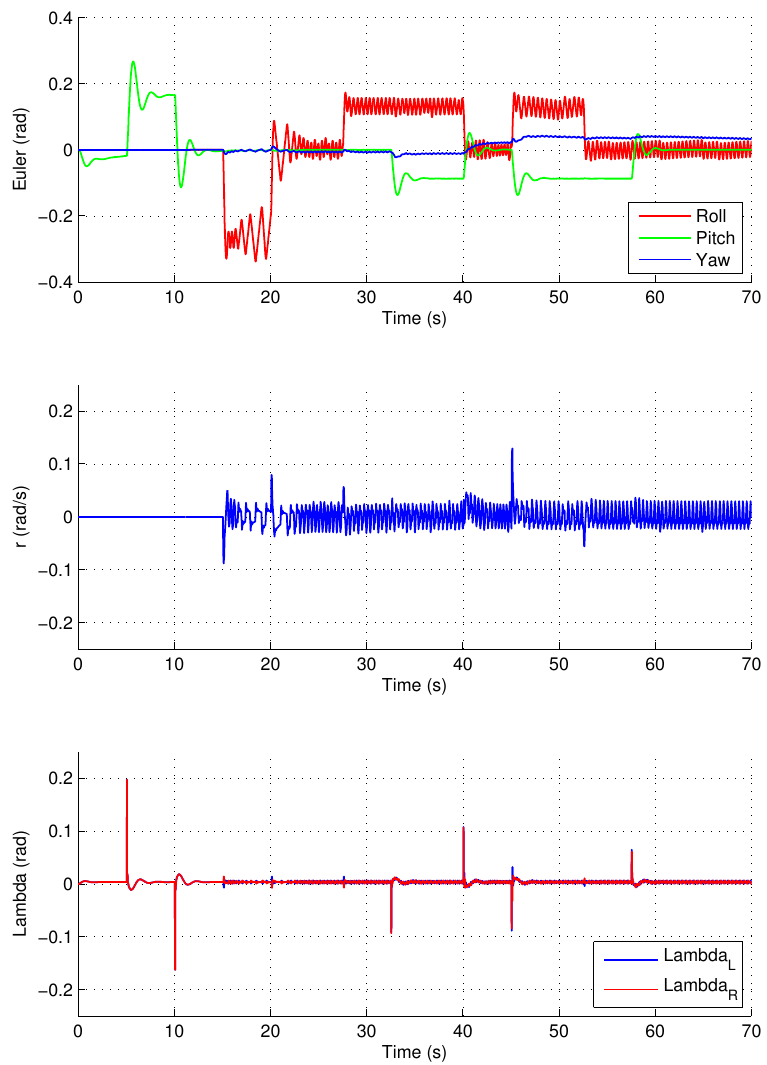
Figure 11. Evolution of r and λ against modifications in φ and θ